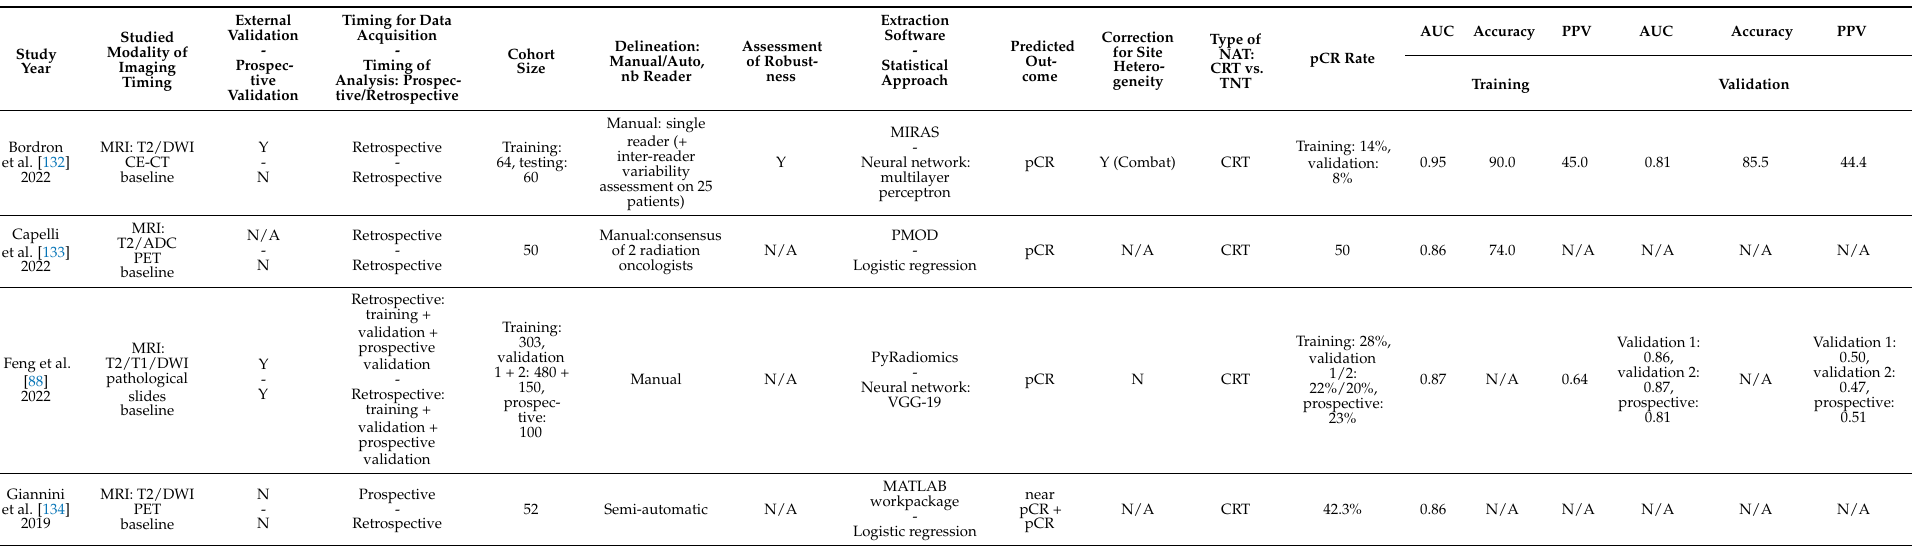
Table 2. Summary of MRI-combined-based radiomics prediction